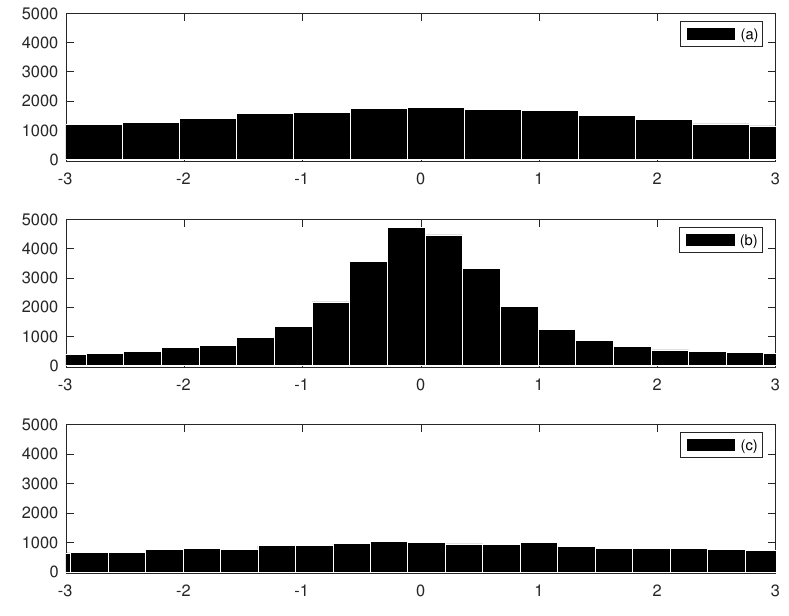
Figure 3. Coefficients distribution. All algorithms (IHT, OMP, GPSR, and Twist) were used in the reconstruction process. The sparse vector signals and the sample matrix were used as inputs, and the outputs were a PSNR-based relationship between the rebuilt signal and the original signal, as well as the number of rebuilt samples (M). Figure 4 shows that the Twist algorithm achieves the highest reconstruction index in terms of M.